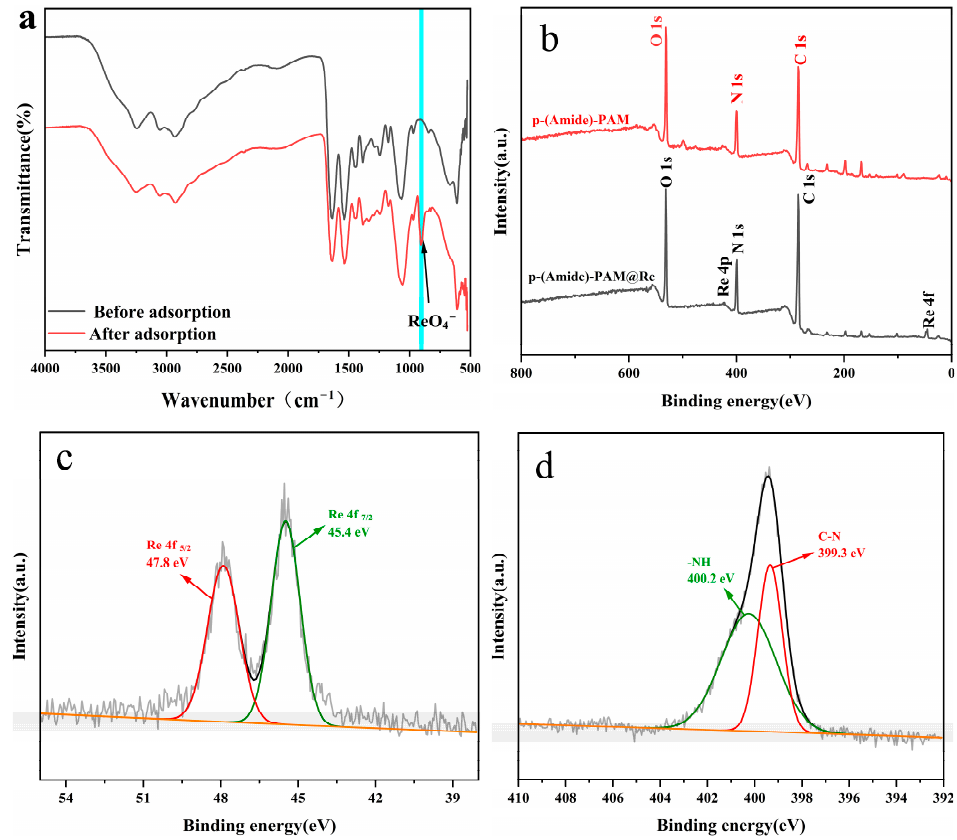
Figure 8. FT-IR spectra ( a ) and XPS wide scan spectrum ( b ) of p-(Amide)-PAM and p-(Amide)- PAM@Re; XPS Re 4f spectrum ( c ) and XPS N 1s spectrum ( d ) of p-(Amide)-PAM@Re.